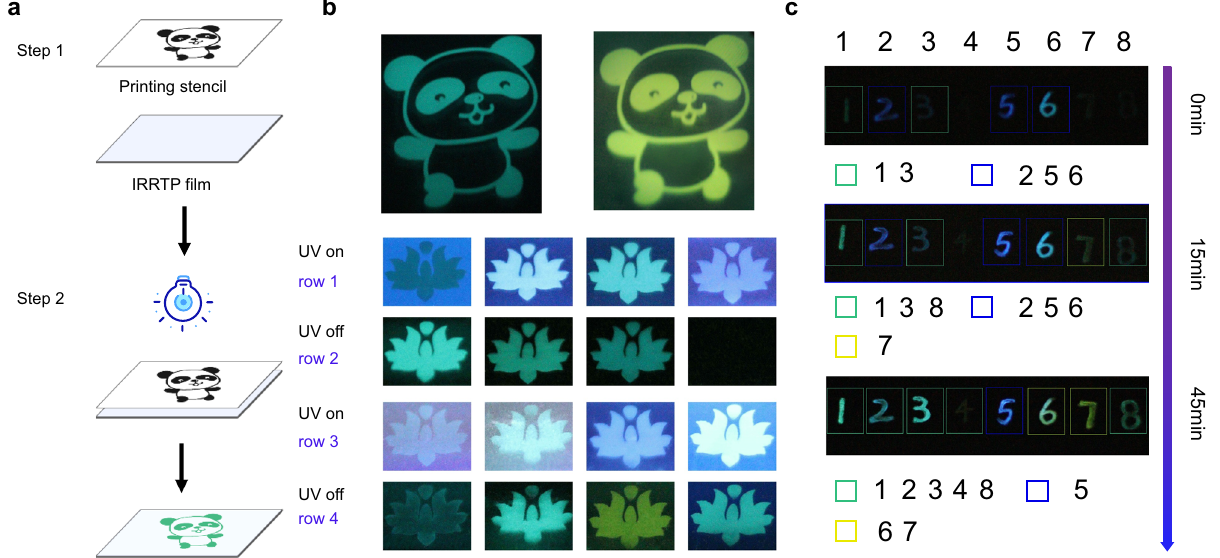
Fig. 5 UV irradiation-responsive IRRTP for green screen printing and multilevel information encryption. a Screen printing process for patterning. Flat IRRTP fi lms were fabricated by drop-coasting the premixed solution on 75 mm × 25 mm glass substrate, followed by drying at 65 °C for 3 h. Then, the designed images were superimposed and fi xed on the fi lm surface. The obtained layers were continuously irradiated by a portable 254 nm UV lamp for 45 min to fi nish the printing progress. b IRRTP photographs of panda and lotus patterns. Green and yellow panda patterns were printed with SDP-based and 2,2-DB-based fi lms, respectively. In row 1, from left to right, printed lotus by SDP, ODP, TDP, and ABP-based fi lms under 254 nm UV lamp. In row 3, from left to right, printed lotus by DP, 4,4-DB, 2,2-DP, and BFPE-based fi lms under 254 nm UV lamp. In rows 2 and 4, from left to right, corresponding printed lotus after turning off 254 nm UV lamp for 0.5 s. c Irradiation time-dependent anticounterfeiting photographs (after turning off UV light for 0.5 s) of eight doped fi lms as the inks under ambient conditions. Numbers 1 – 8 were encrypted with SDP, ODP, TDP, ABP, DP, 4,4-DB, 2,2-DP, and BFPE-based fi lms, respectively. Changeable encrypted information was shown by irradiation for 0, 15, and 45 30mg/mL. Eight homogeneous solutions were obtained after ultrasonication for 5h, which were then left standing for one hour. Secondly, a series of fi lms was fabricated by a drop-casting the prepared aqueous solutions on 75mm ×25 mm glass substrates. Then, these fi lms were dried at 65°C for 3 h. Lastly, the designed images were superimposed and fi xed on the fi lm surface, and the double layers were irradiated by a portable UV-254 nm lamp for 45 min to generate the printing patterns. Data availability All the other data supporting the fi ndings of this study are available within the article and its supplementary information fi les and from the corresponding author upon reasonable request.